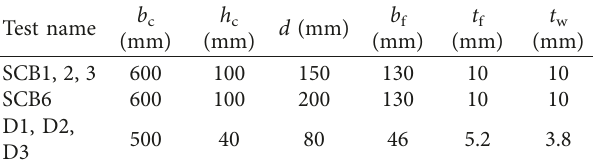
Table 1: Cross-sectional data for experimental studies [11, 16].